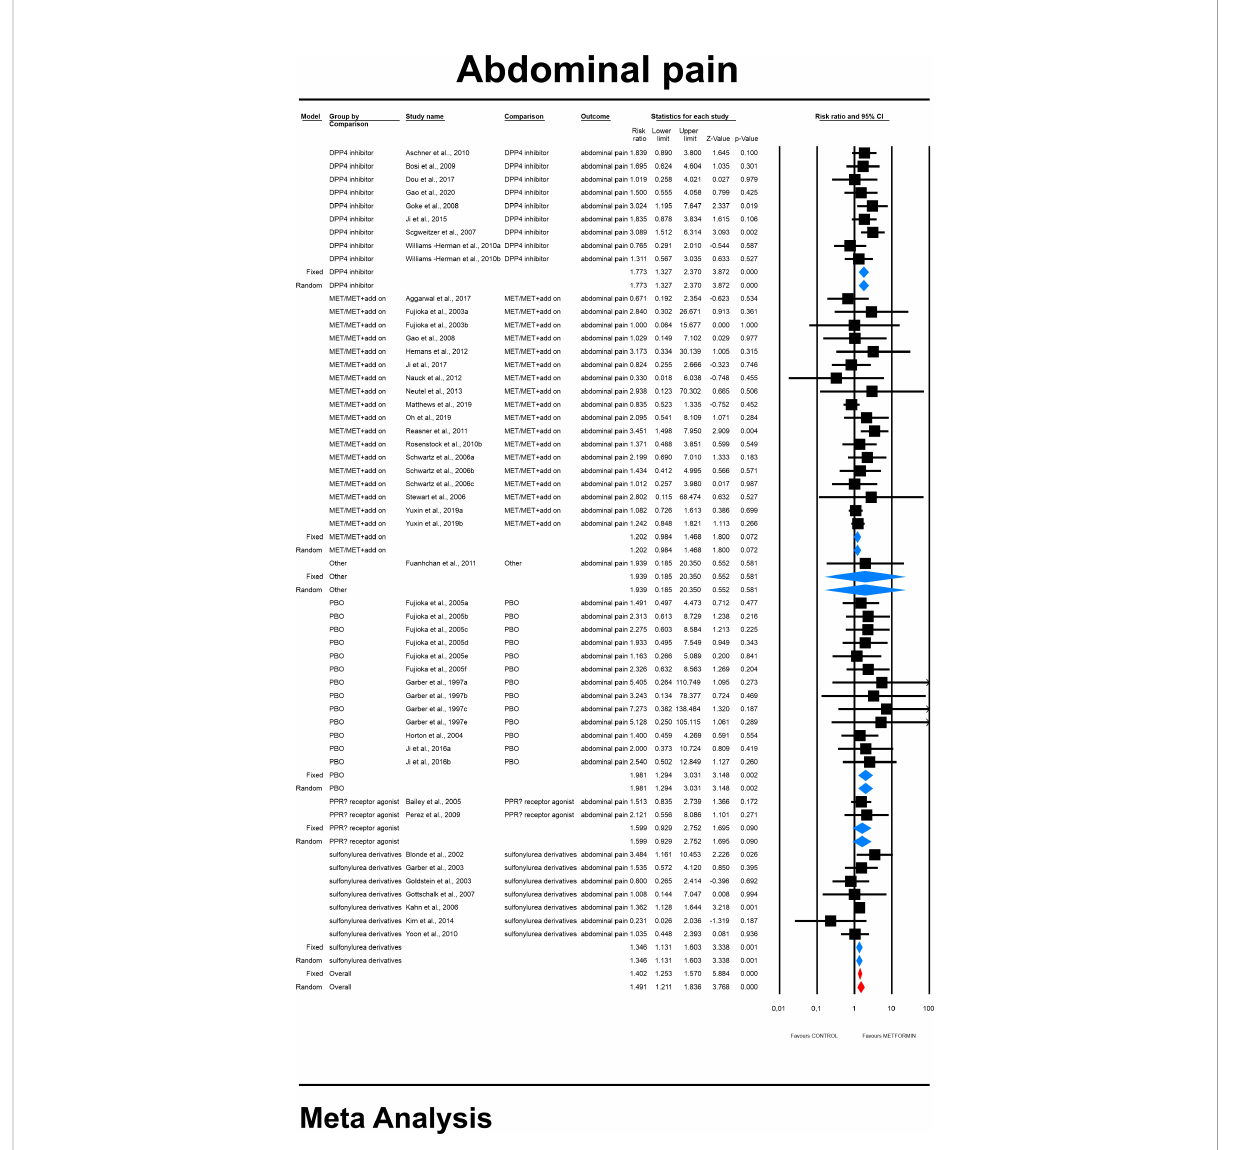
FIGURE 2 The effect size (RR) for the abdominal pain in patients taking metformin (intervention) vs. comparator